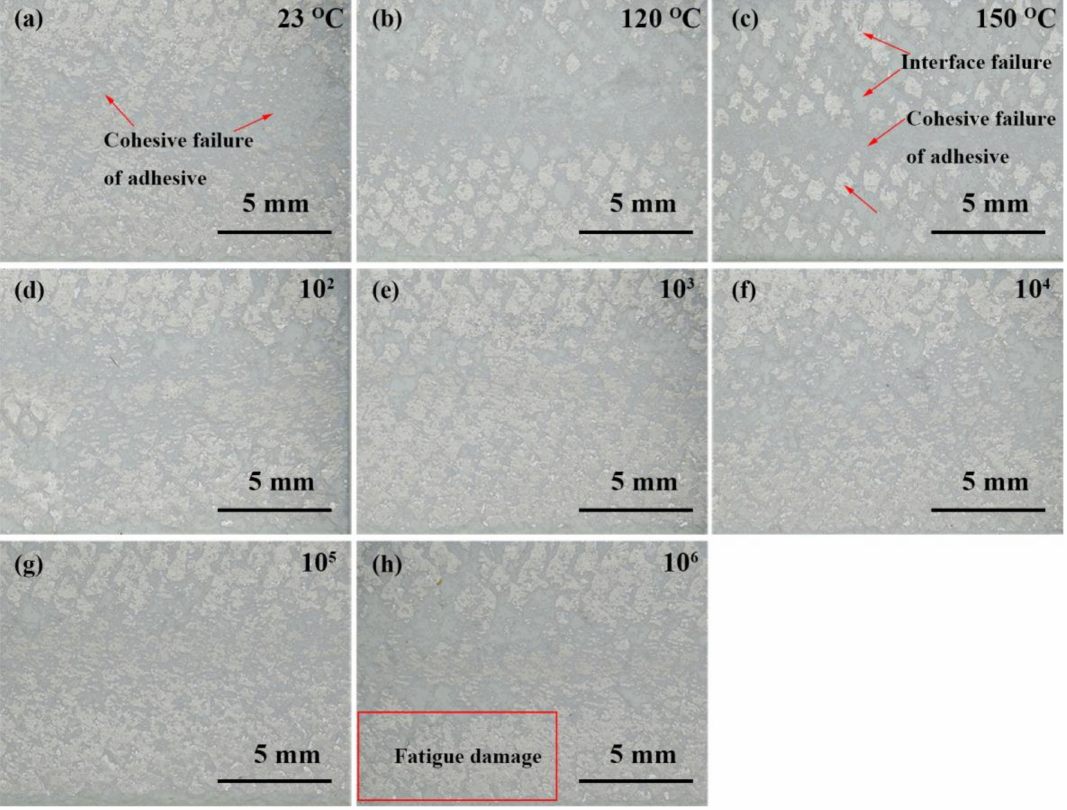
Figure 10. The failure mode of Ep/PHO30/nBN30 film adhesive under different test conditions: ( a ) 23 ◦ C, ( b ) 120 ◦ C, ( c ) 150 ◦ C, ( d ) after 10 2 fatigue cycles, ( e ) after 10 3 fatigue cycles, ( f ) after 10 4 fatigue cycles, ( g ) after 10 5 fatigue cycles, and ( h ) after 10 6 fatigue cycles.